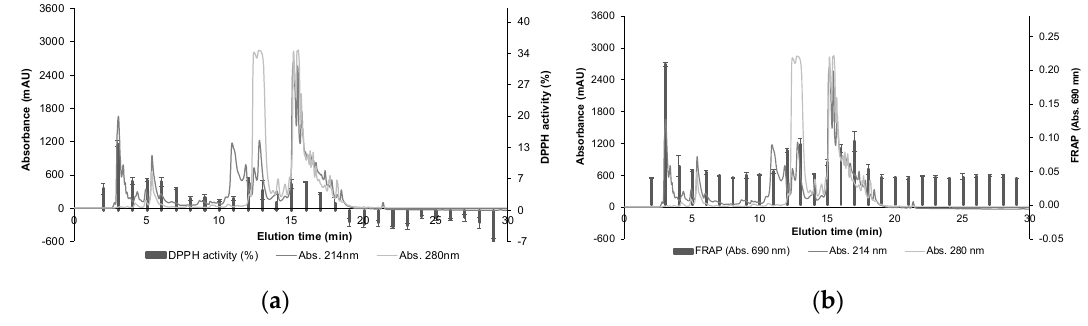
Figure 4. RP-HPLC profile of the selected pooled fractions (f9–f12) of tomato by-products hydrolysate obtained from size-exclusion chromatography, and antioxidant activity determined by ( a ) DPPH radical scavenging activity and ( b ) ferric reducing antioxidant power (FRAP) of the collected fractions.